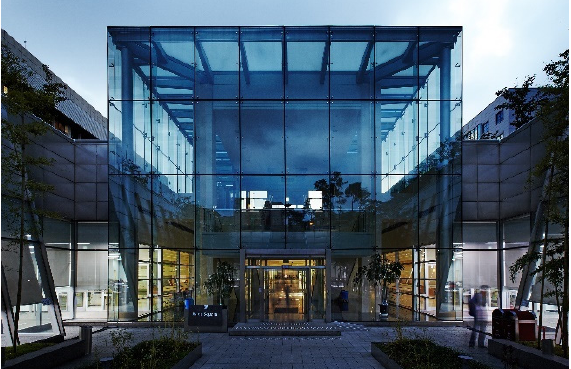
Figure 14. C ampus Building B (Hana Square). Figure 14. Campus Building B (Hana